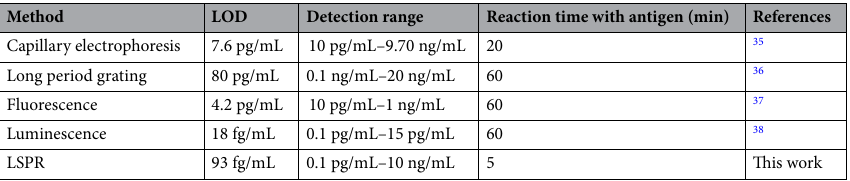
Table 1. A comparison of sensing parameters between the Tg detection methods.